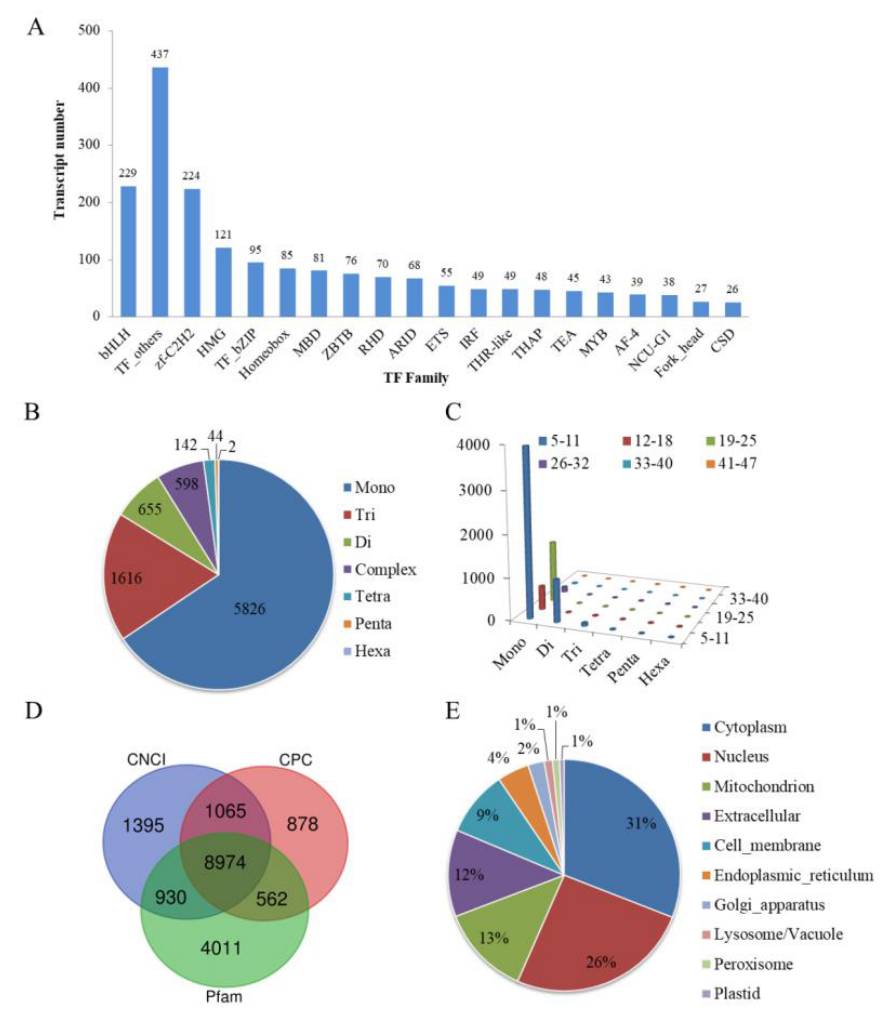
localization of the transcripts, most of which were located in the cytoplasm, nucleus, mitochondrion, extracellular, and cell membrane (Figure 2E).